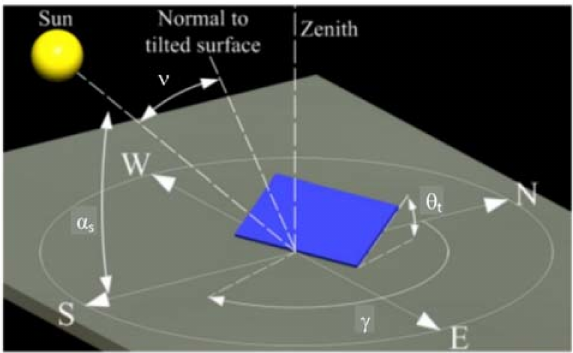
Figure 10. Schematic representation of the azimuthal, altitude, and tilt angles for a given solar cell panel.